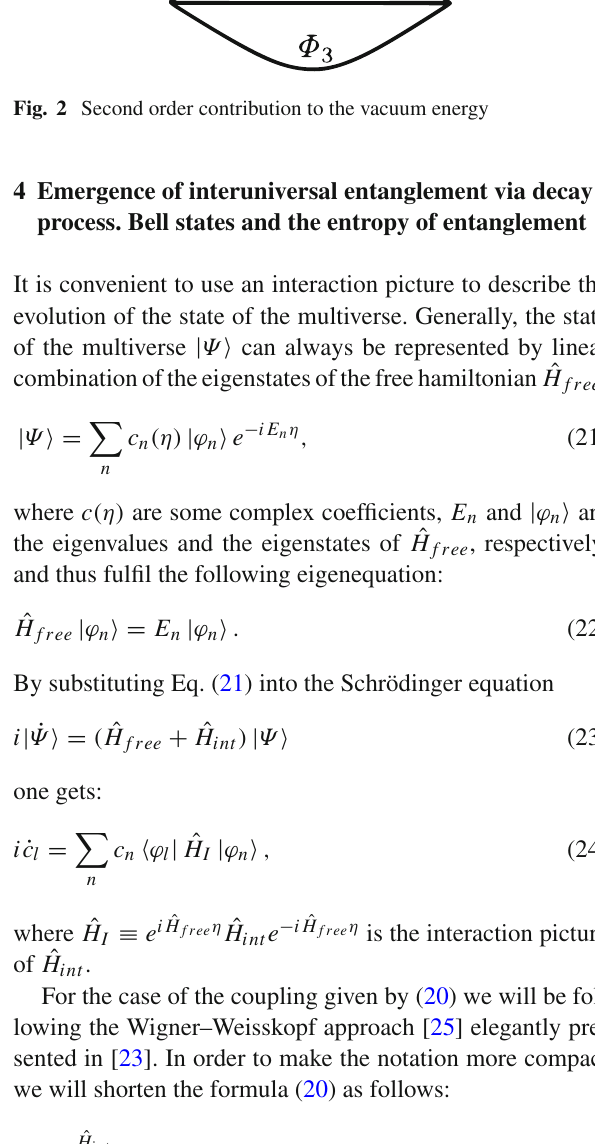
Fig. 2 Second order contribution to the vacuum energy